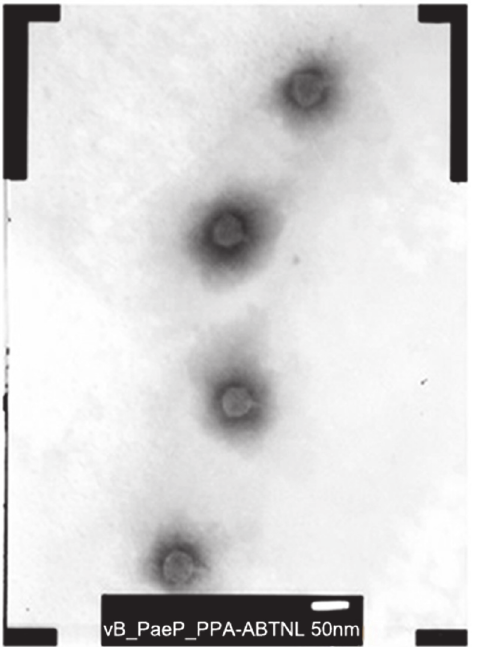
Figure 1. Transmission electron micrograph of phage PPA-ABTNL negatively stained with uranyl acetate. Scale bar represents 50 nm.